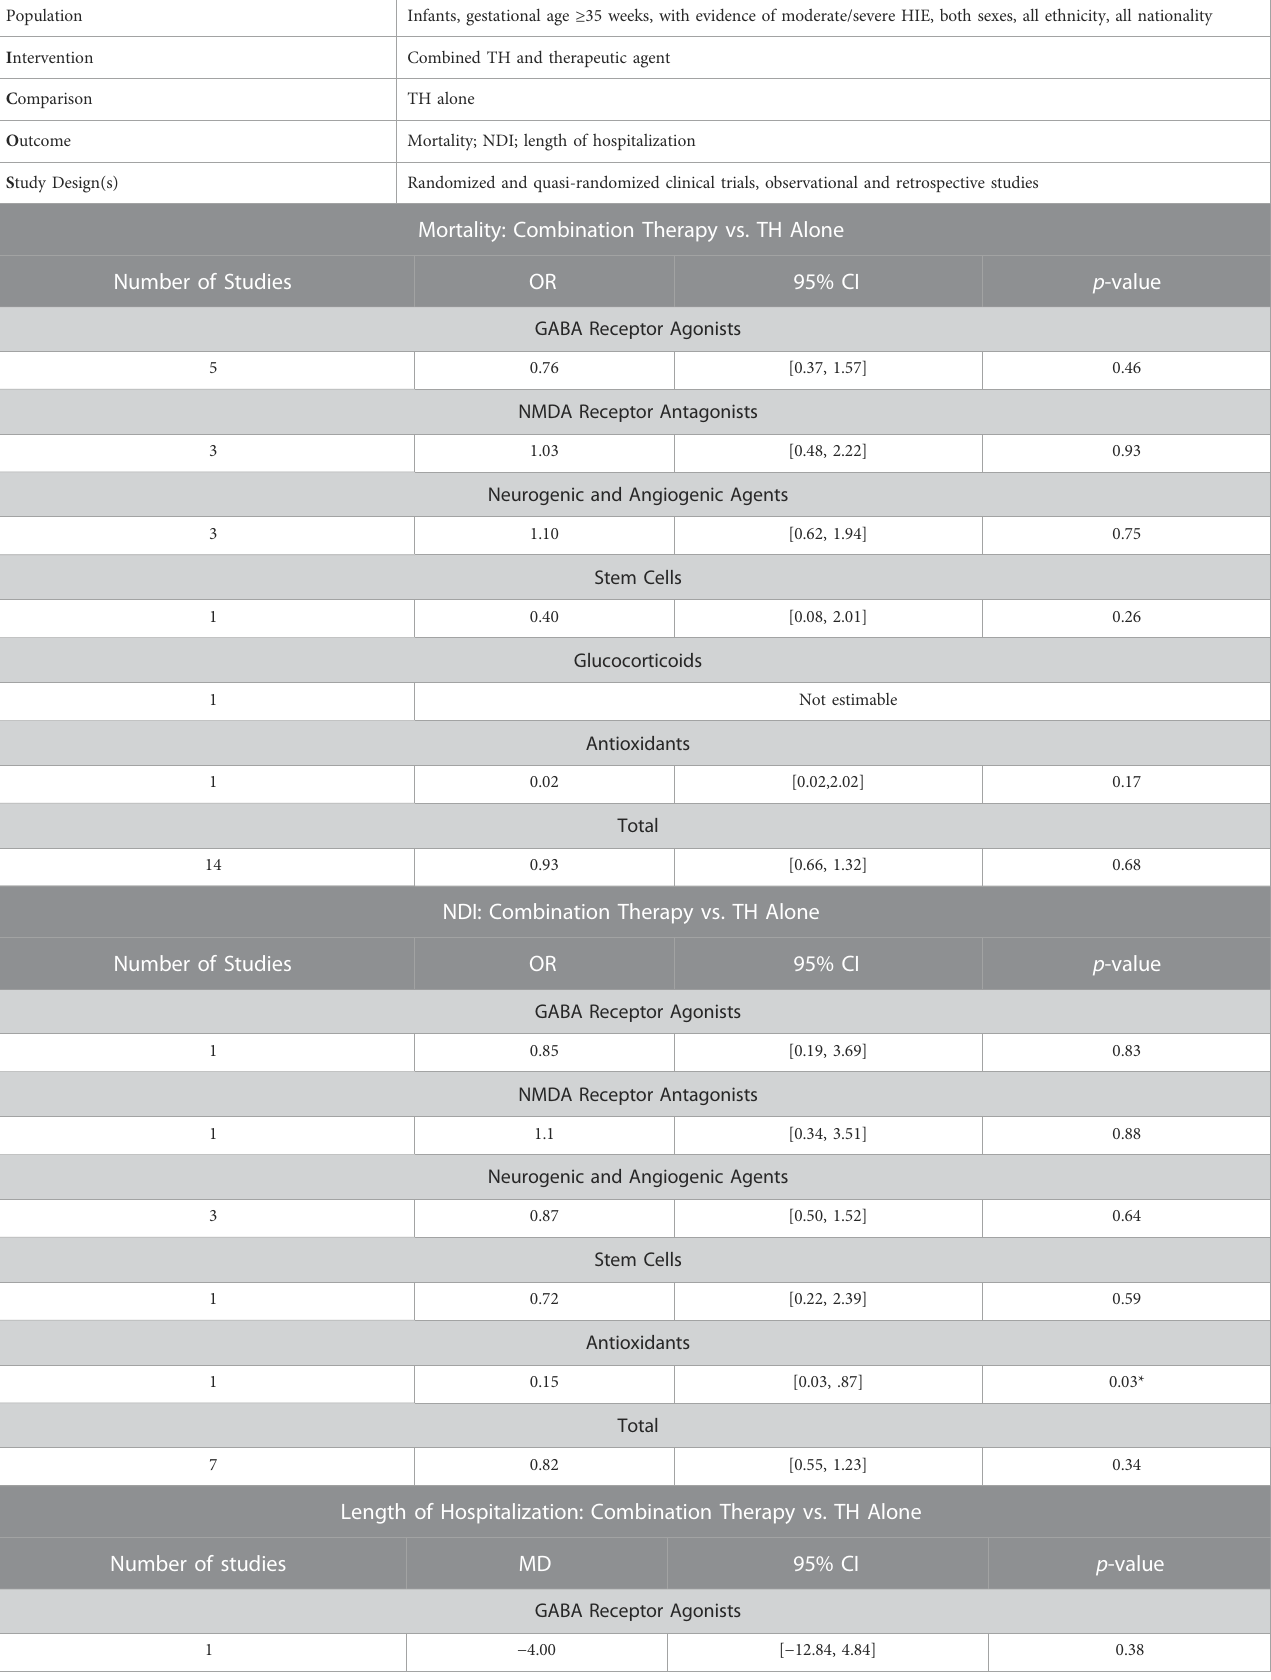
TABLE 3 Summary of fi ndings table for outcomes assessed. Effect sizes [odds ratio (OR): mortality, NDI; mean difference (MD): length of hospitalization], 95% con fi dence intervals (95% CI) and two-tailed p -values.